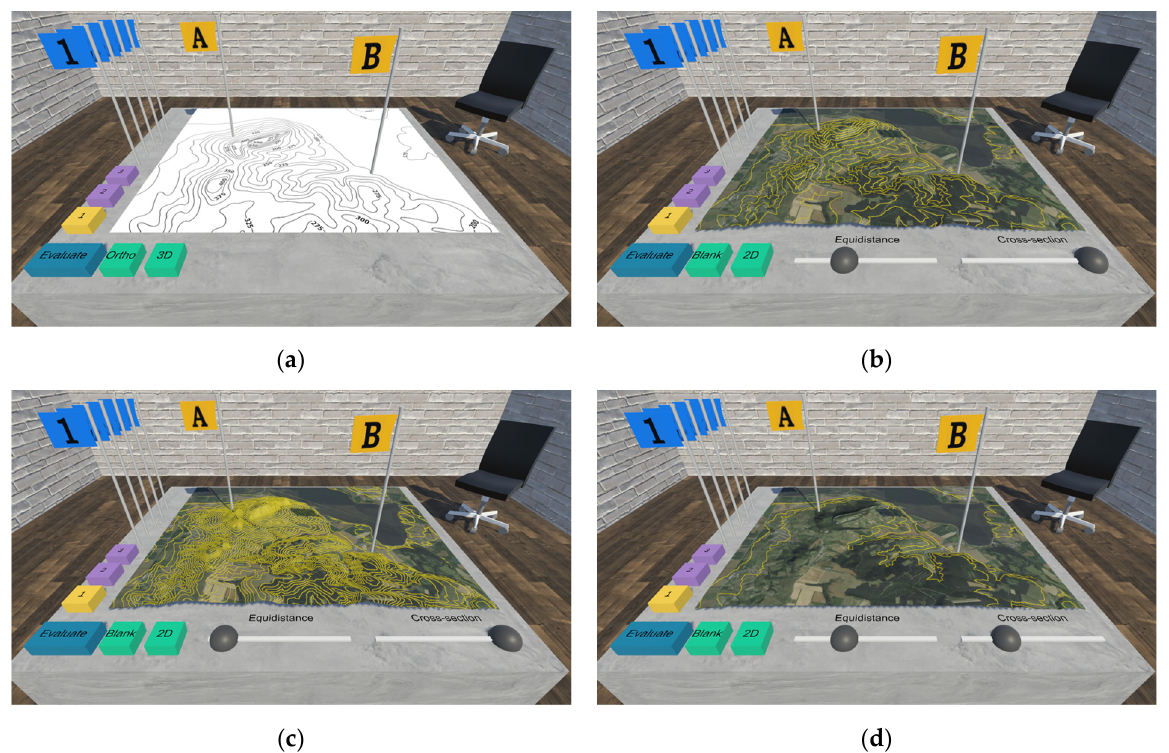
Figure 1. Example of a map in CIVE. ( a )—2D blank map with contour lines; ( b )—3D model with contour lines; ( c )—3D model with changed contour lines interval by the Equidistance slider; ( d )—cross-section of the highest parts of the terrain. On the table –There are purple buttons 1, 2, 3 for different terrains on the left, a blue “Evaluate” button to evaluate visibility between flags A and B, a green “Blank/Ortho” button to switch blank map with orthophoto map, a green “2D/3D” switch button, an “Equidistance” slider for the dynamic setting of contour equidistance, and a “Cross-section” slider to cut upper parts of the terrain.